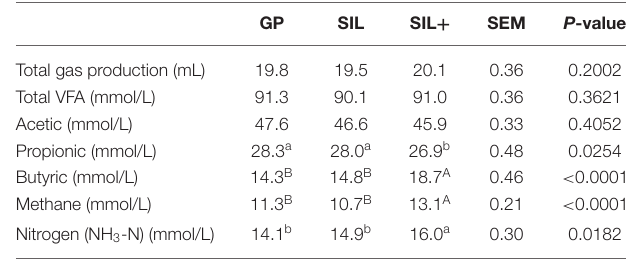
TABLE 6 | In vitro gas production in grape pomace (GP), after silage with (SIL + ) or without (SIL) L. plantarum